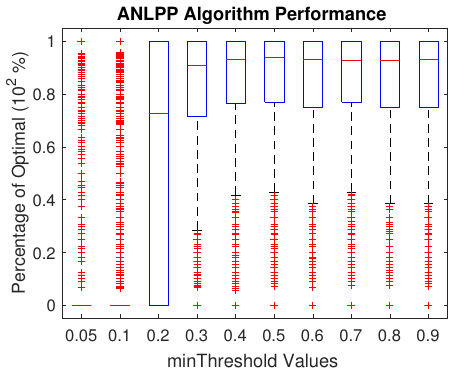
Figure 5. The impact of minThreshold on the performance of All Network Least Possible Probability (ANLPP).